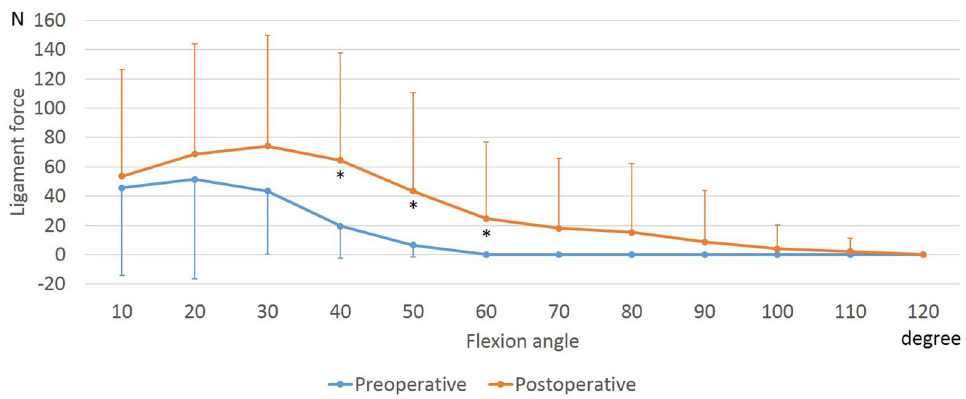
Figure 4. Force of the anteromedial bundle of the anterior cruciate ligament during squatting before and after unicompartmental knee arthroplasty. *Significant differences between preoperative and postoperative knees ( p ≤